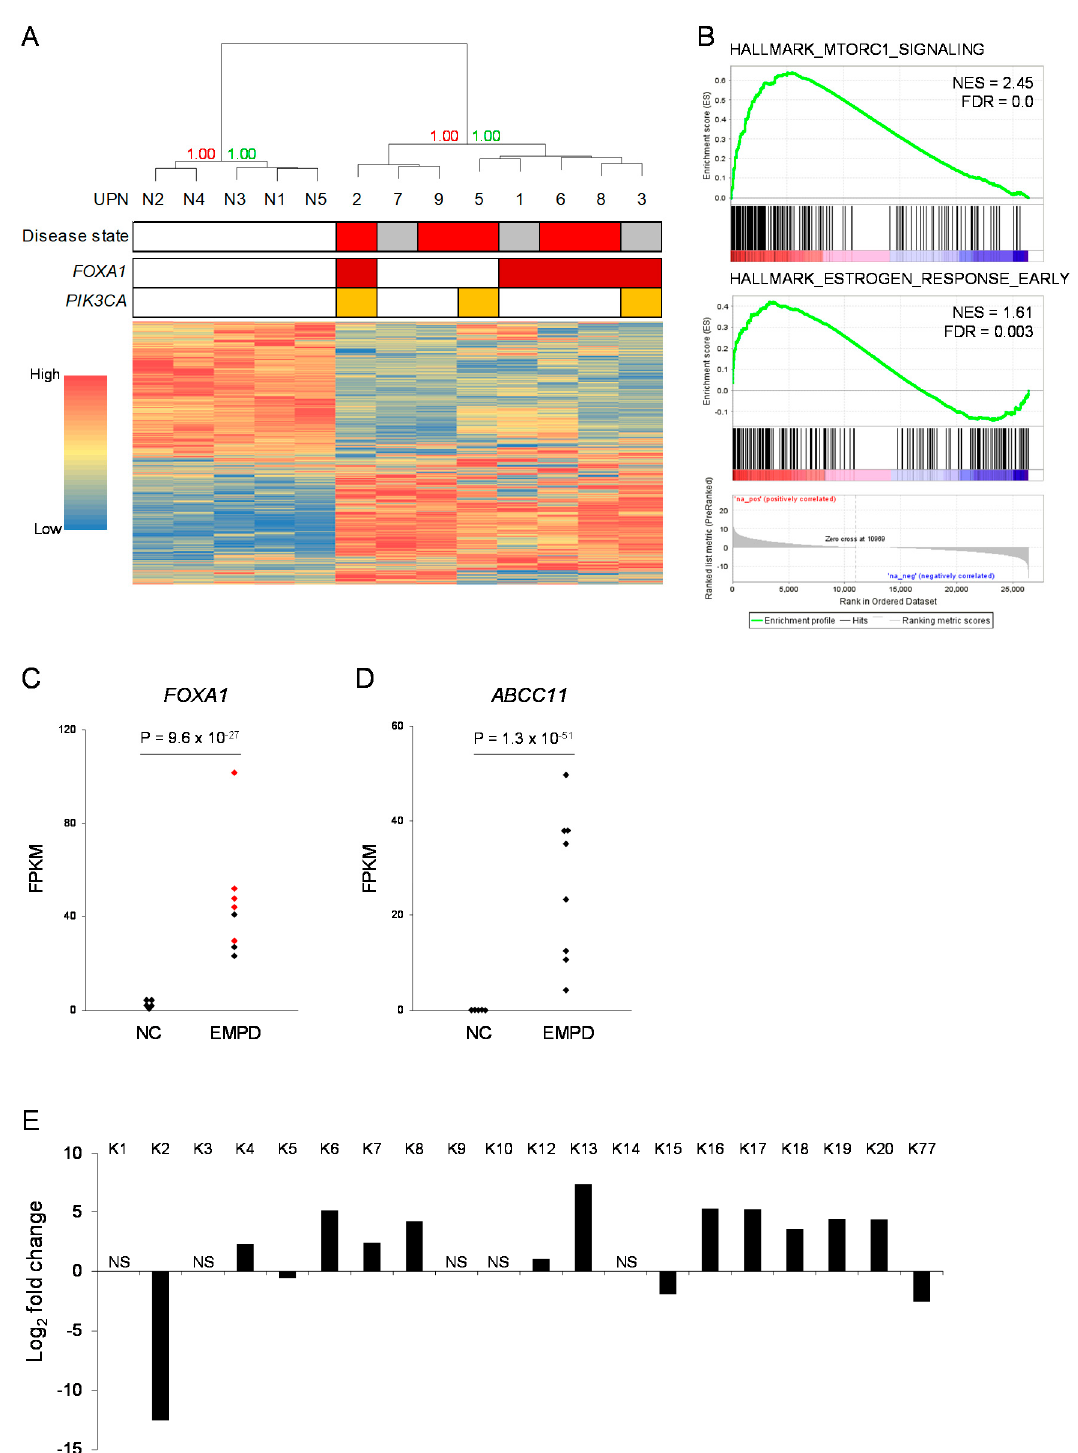
Figure 3. Global gene expression profiling of EMPD. ( A ) Hierarchical clustering using the global expression profiles obtained by RNA-seq. N1–N5 indicate normal skin samples obtained from healthy volunteers. On the disease state line, red and gray boxes indicate invasive disease state and in situ disease state, respectively. Red and green numbers indicate the bootstrap probability and the approximately unbiased p -value, respectively. ( B ) Gene set enrichment analysis using the hallmark gene set database. Genes associated with mTOR signaling (HALLMARK_MTORC1_SIGNALING) and estrogen response (HALLMARK_ESTROGEN_RESPONS_EARLY) are relatively upregulated in EMPD samples. NES, normalized enrichment score; FDR, false discovery rate. ( C , D ) Expression levels (fragments per kilobase per million; FPKM) of FOXA1 ( C ) and ABCC11 ( D ). Red dots in ( C ) indicate